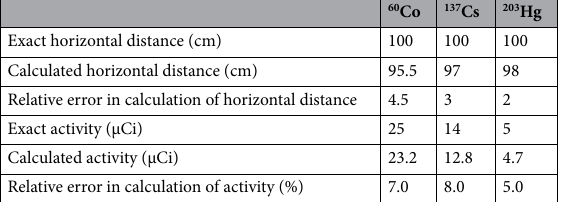
Table 8. Relative error in determining positions and activities of 60 Co, 137 Cs and 203 Hg in the hypothetical